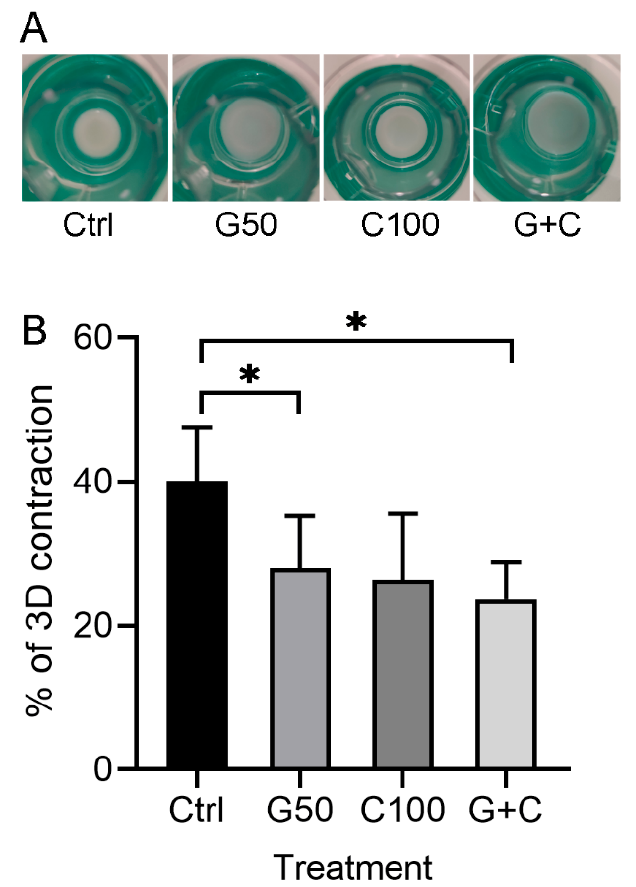
Figure 3. Macroscopic appearance and contraction of the 3D GTEs generated with the TIGKs and the hGFBs-populated collagen gels with/without genipin or/and cytochalasin D direct crosslinking for 2-week air–liquid interface culture. ( A ). Macroscopic appearance of the 3D GTEs by the 2-week air–liquid interface culture. ( B ). Contraction (%) of the 3D GTEs after 2-week airiquid interface cul- ture. Abbreviations: hGFBs: hTERT-immortalized gingival fibroblasts; TIGKs: hTERT-immortalized gingival keratinocytes. Ctrl: control; G50: 50 µM genipin; C100: 100 nM cytochalasin D; G + C: G50 + C100. *: p < 0.05.